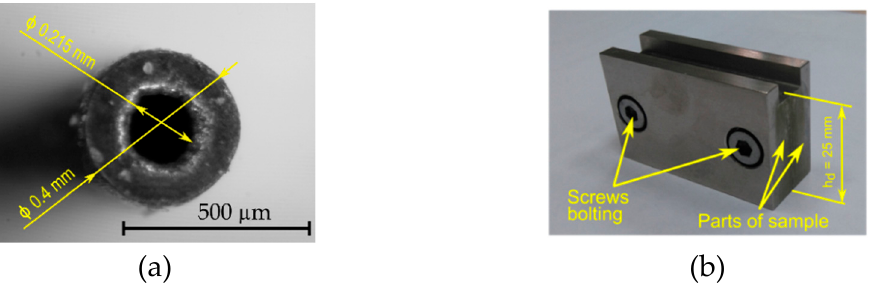
Figure 1. ( a ) Tool electrode tip and ( b ) photograph of the sample; h d —the maximum drilling depth. Table 1. Chemical composition of Inconel 718 (wt. %).